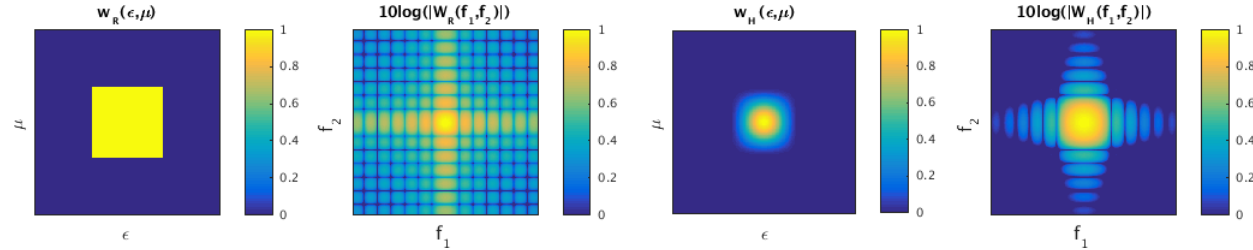
Figure 2. FT pairs for rectangular and Hanning windows (values normalised to unity).